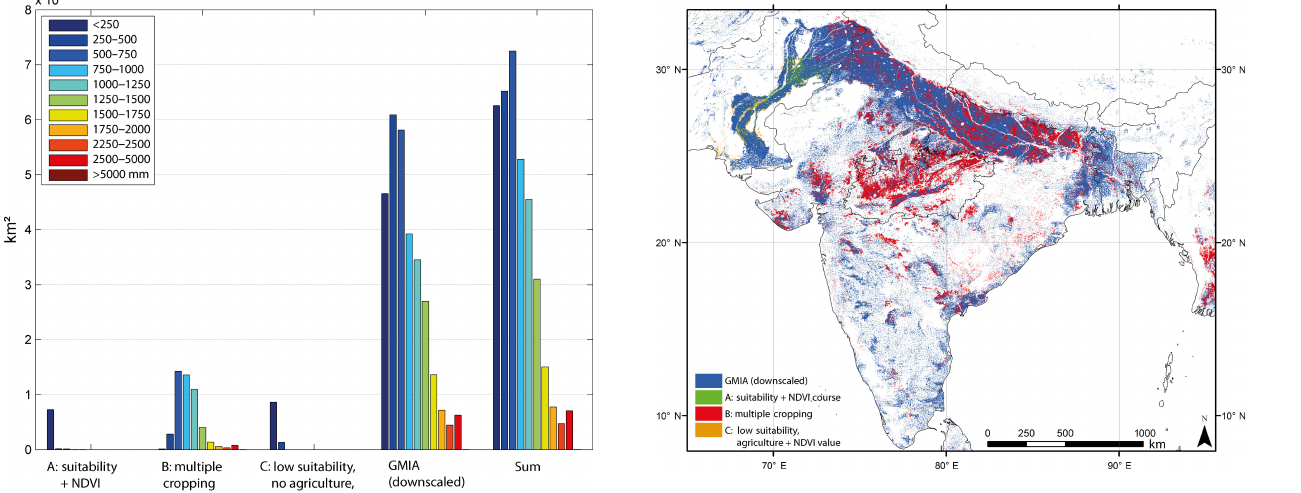
Figure 7. The Indian subcontinent and its identified irrigated areas. The blue areas are the information of the downscaled GMIA. Irri- gation is more dense than expected in already irrigated regions and new areas appear in the state Madhya